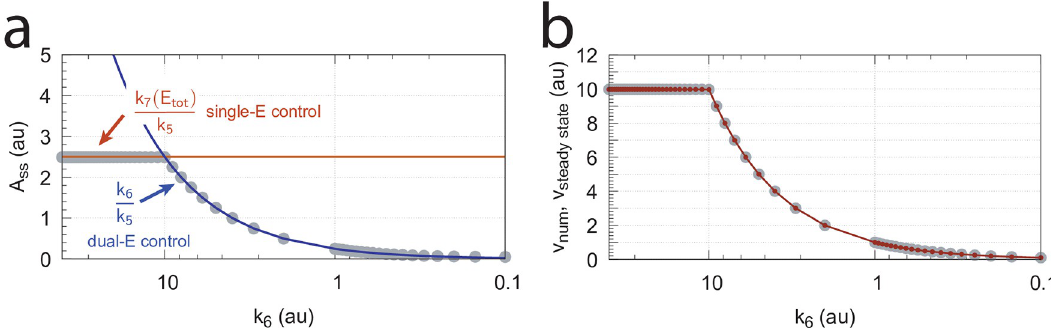
Fig 13. Switch between single-E and dual-E control for the m2 controller when E 1 and E 2 are removed by a compulsory-order ternary-complex mechanism with E 2 binding first to Ez (Fig 11b). Panel a: steady state values of A ( A ss ) as a function of k 6 . Gray dots show numerical results. The line outlined in red describes the set-point of A ( k 7 Ez / k 5 ) at single-E control. The blue line shows tot the set-point of A ( k 6 / k 5 ) when the system is in dual-E control mode. Panel b: corresponding numerical (gray dots) and steady state values (red small dots, calculated by King-Altman method, S1 Text) of the degradation rate v of the ternary-complex (Eq 13). Rate constants: k 1 =0.0, k 2 =100.0, k 3 =1 × 10 5 , k 4 =1.0, k 5 =4.0, k 6 varies between 40.0 and 0.05, k 7 =1 × 10 7 , k 8 =0.1, k 13 = k 15 =1 × 10 8 , k 14 = k 16 =1 × 10 3 . Initial concentrations: A 0 =1.0, E 1,0 =9.1 × 10 2 , E 2,0 =6.7 × 10 − 2 , Ez 0 =6.0 × 10 − 7 , (E 1 � Ez � E 2 ) 0 =4.0 × 10 − 7 , (Ez � E 2 ) 0 =4.4 × 10 − 11 . Ez tot =1.0 × 10 − 6 . Steady state values were obtained after 10000 time